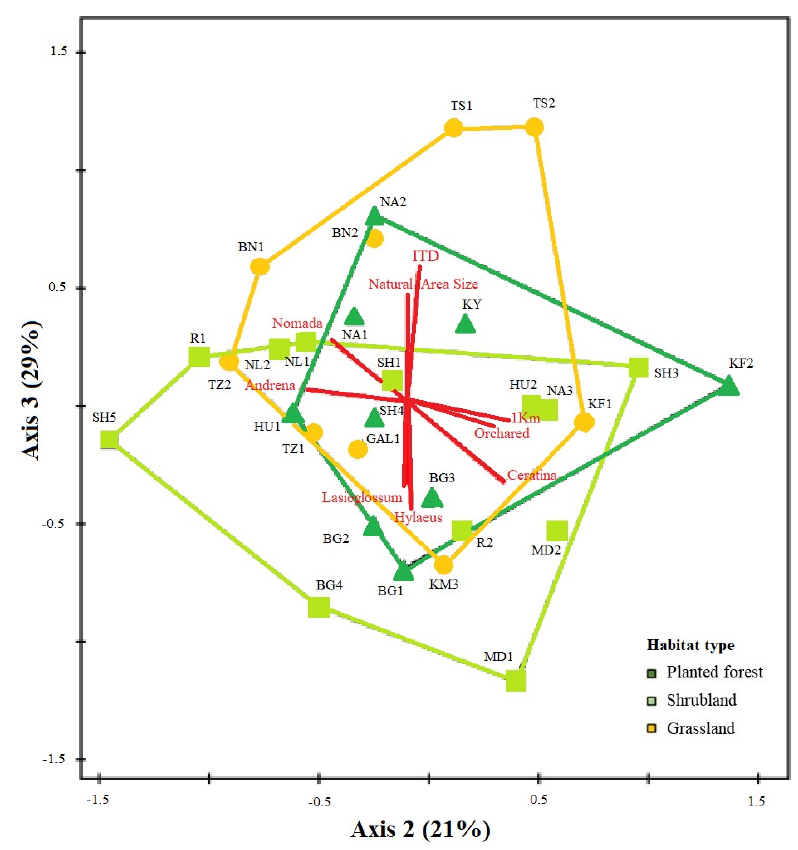
Figure 4. Bee species composition in the three uncultivated habitats based on NMS ordination, and vectors of correlated environmental variables (in red): the percentage of orchards and uncultivated habitats (Natural Area Size) within 1 km radius buffers, bee body size (ITD), and dominant bee genera. Three dimensions; p < 0.01, Stress = 16.3, 60% of variance explained.